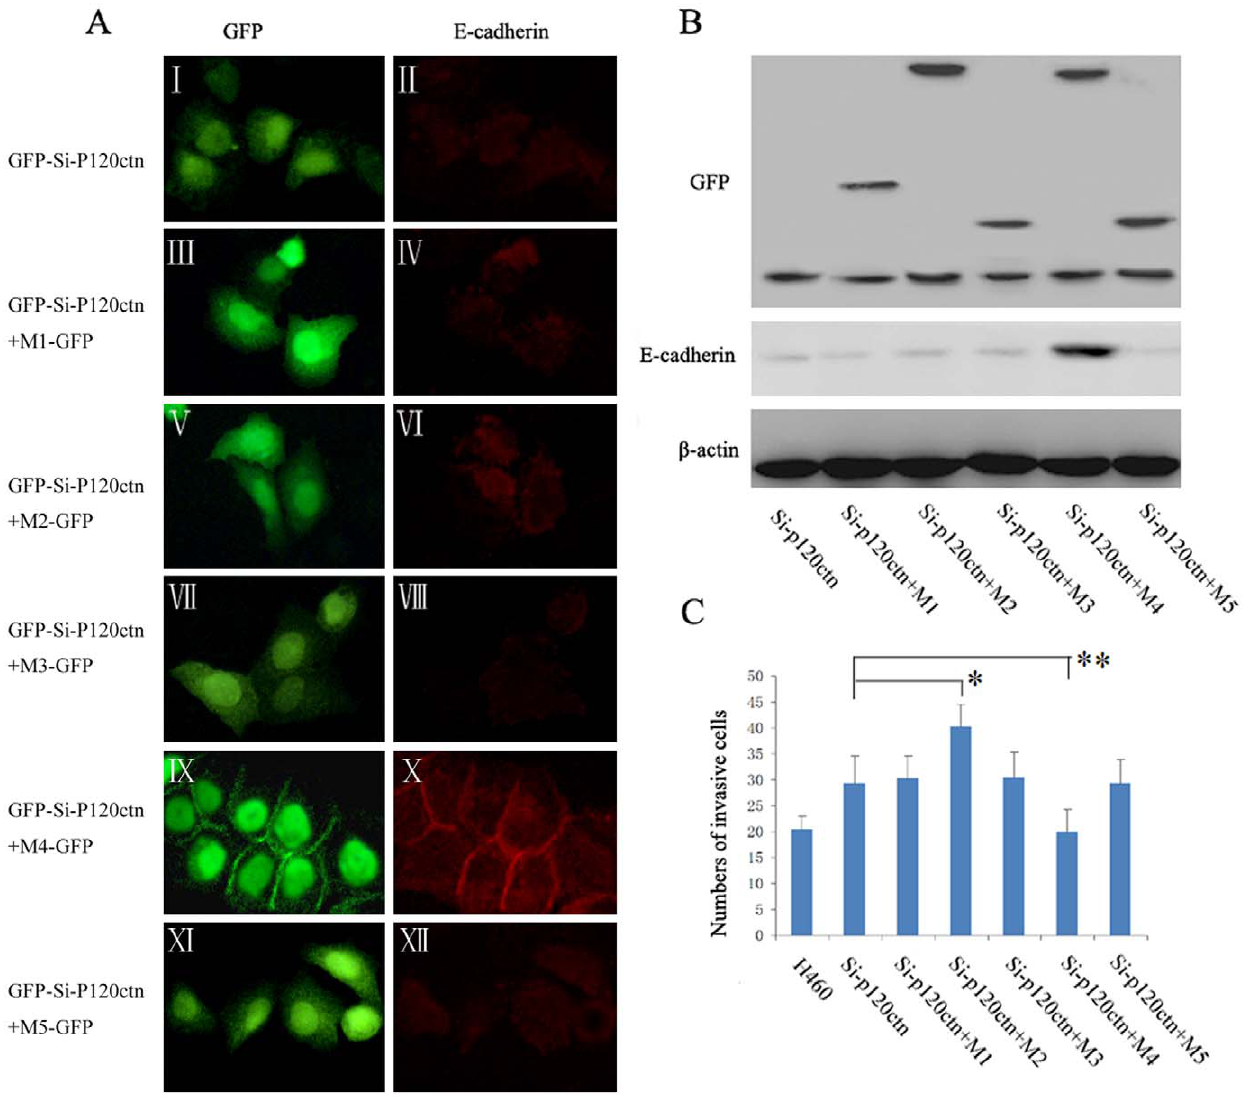
Figure 5. Mutant 4 restored the E-cadherin to cell membrane and suppressed cell invasiveness in H460 cells. H460 cells were transiently transfected with GFP-siRNA-p120ctn plasmids. 24 hours after transfection, an aliquot of the cells was transfected again with one of the five p120ctn isoform 1A deletion mutants M1–5 cDNA plasmids or with empty vector as control (The group transfected with vector alone was not included in the data). ( A ) Levels and localization of E-cadherin were analyzed by immunofluorescence. The green signal indicates expression of GFP from GFP-siRNA-P120ctn construct in image I and represents combined expression of GFP from GFP-siRNA-P120ctn and M1–5-GFP in images III, V, VII, IX and XI. GFP from GFP-si-P120ctn, M1–M3, and M5-GFP was expressed in the nucleus and cytoplasm. GFP from GFP-si-P120ctn and M4-GFP was expressed in the nucleus, cytoplasm and on the cell membrane (IX). Expression or repletion of M4 mutant (IX) restored E-cadherin on the cell membrane (X), while expression of the other mutants had no significant effects on E-cadherin levels. ( B ) The levels of E-cadherin were then analyzed by Western blot assay. Expression of M1–M5 mutants were detected by using antibody against GFP. The results showed that expression of M4 mutant up-regulated the E-cadherin levels, whereas the other mutants had no effects on the E-cadherin levels. ( C ) The invasiveness of H460 cells was analyzed by Matrigel invasion assay. Repletion of M4 mutant reduced the cell invasiveness in comparison with the group of p120ctn ablation (Si- p120ctn) (**, P , 0.01), while repletion of M2 mutant enhanced the invasiveness (*, P , 0.01). Repletion of the other mutants (M1, M3 and M5) did not show significant effects on cell invasiveness in comparison with the group of 120ctn ablation.